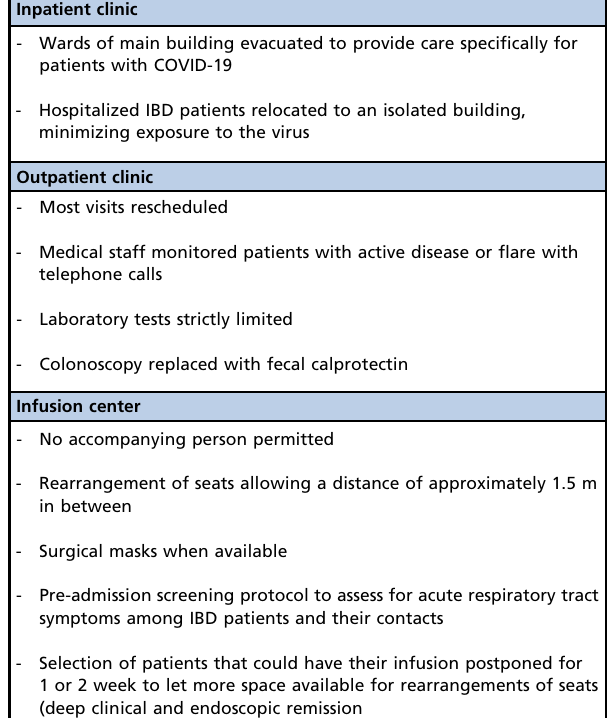
Table 2 - Measures to adapt IBD care during the pandemic.